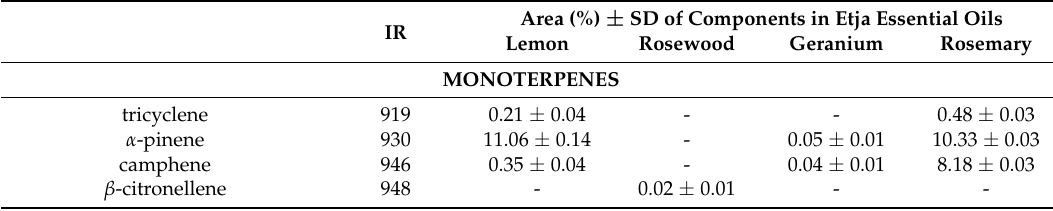
Table 2. The terpene ingredients (%) of the tested essential